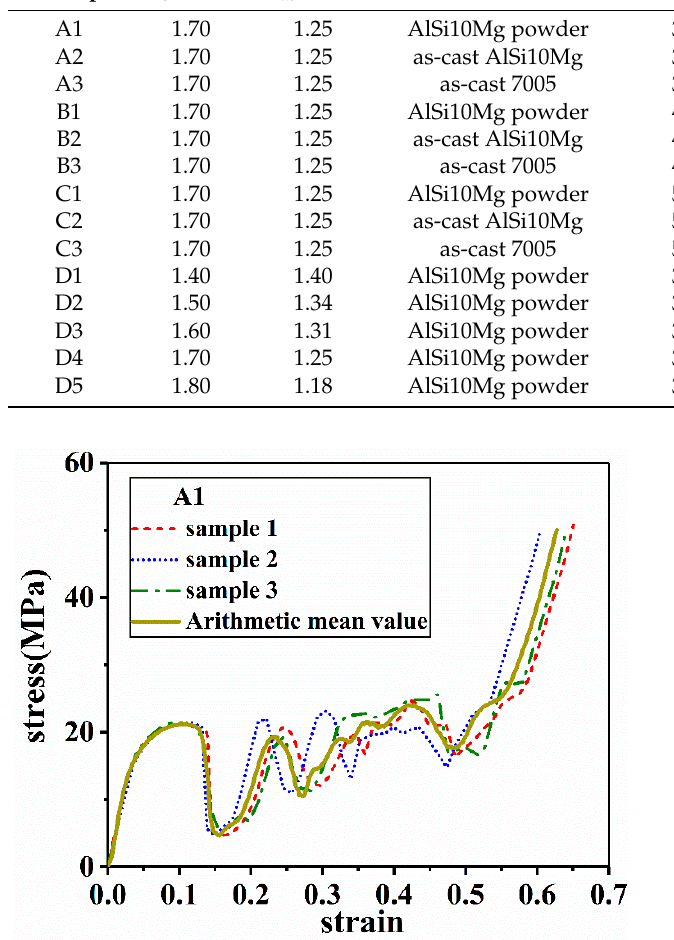
Figure 3. Arithmetic mean value of three experimental data.